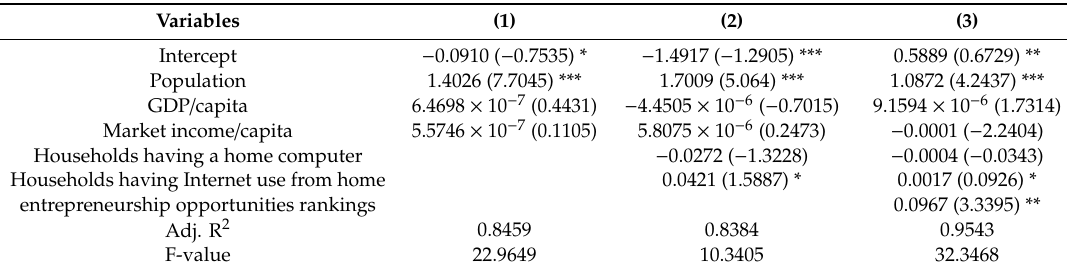
Table 10. Regression results. The dependent variable is the number of crowdfunding providers (2019)